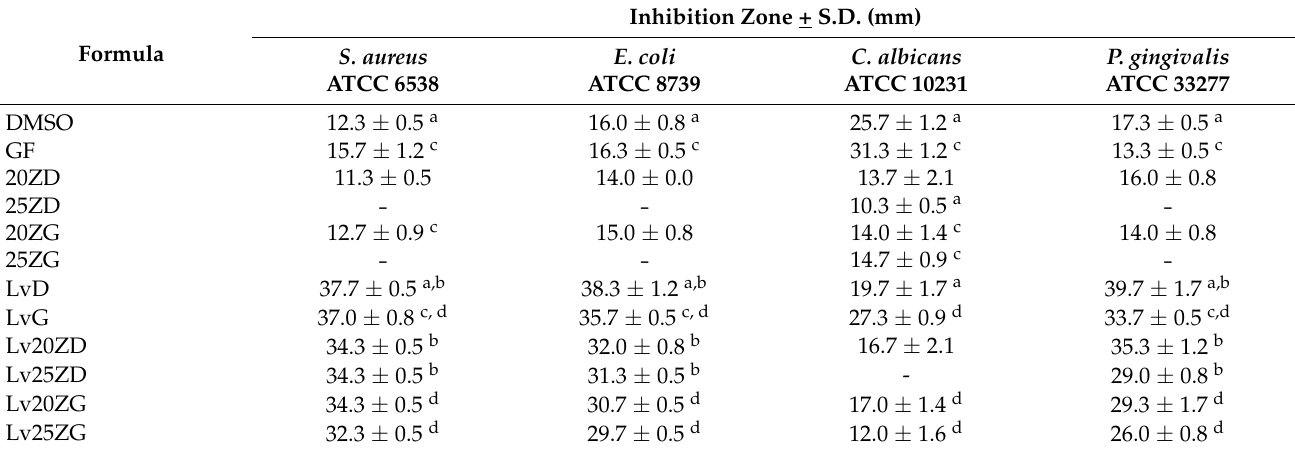
“ - “ = No inhibition zone; the superscripts a – d indicate a significant difference ( p < 0.05) using one- way ANOVA followed by an LSD post-hoc test.